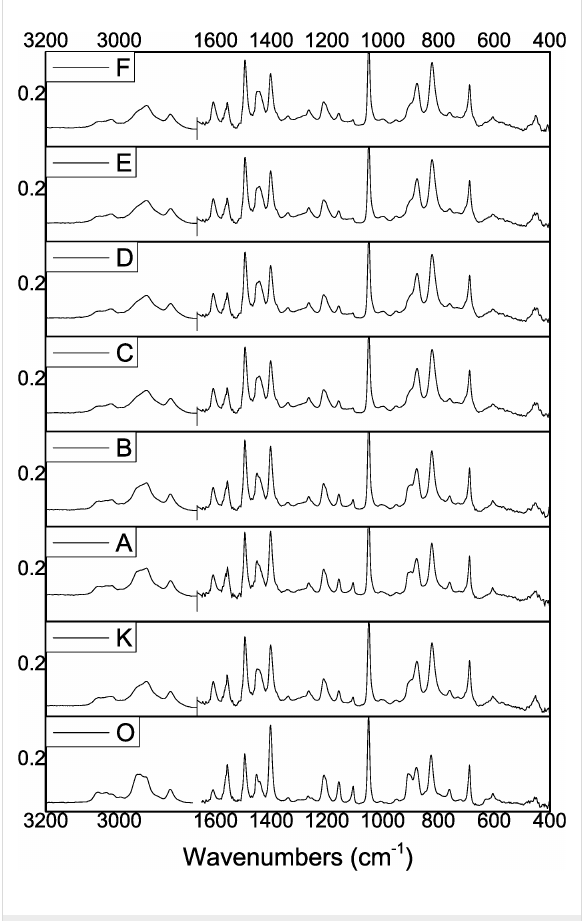
Figure 5: FTIR spectra of pure parylene C (samples O and K) and NCPCs (samples A to